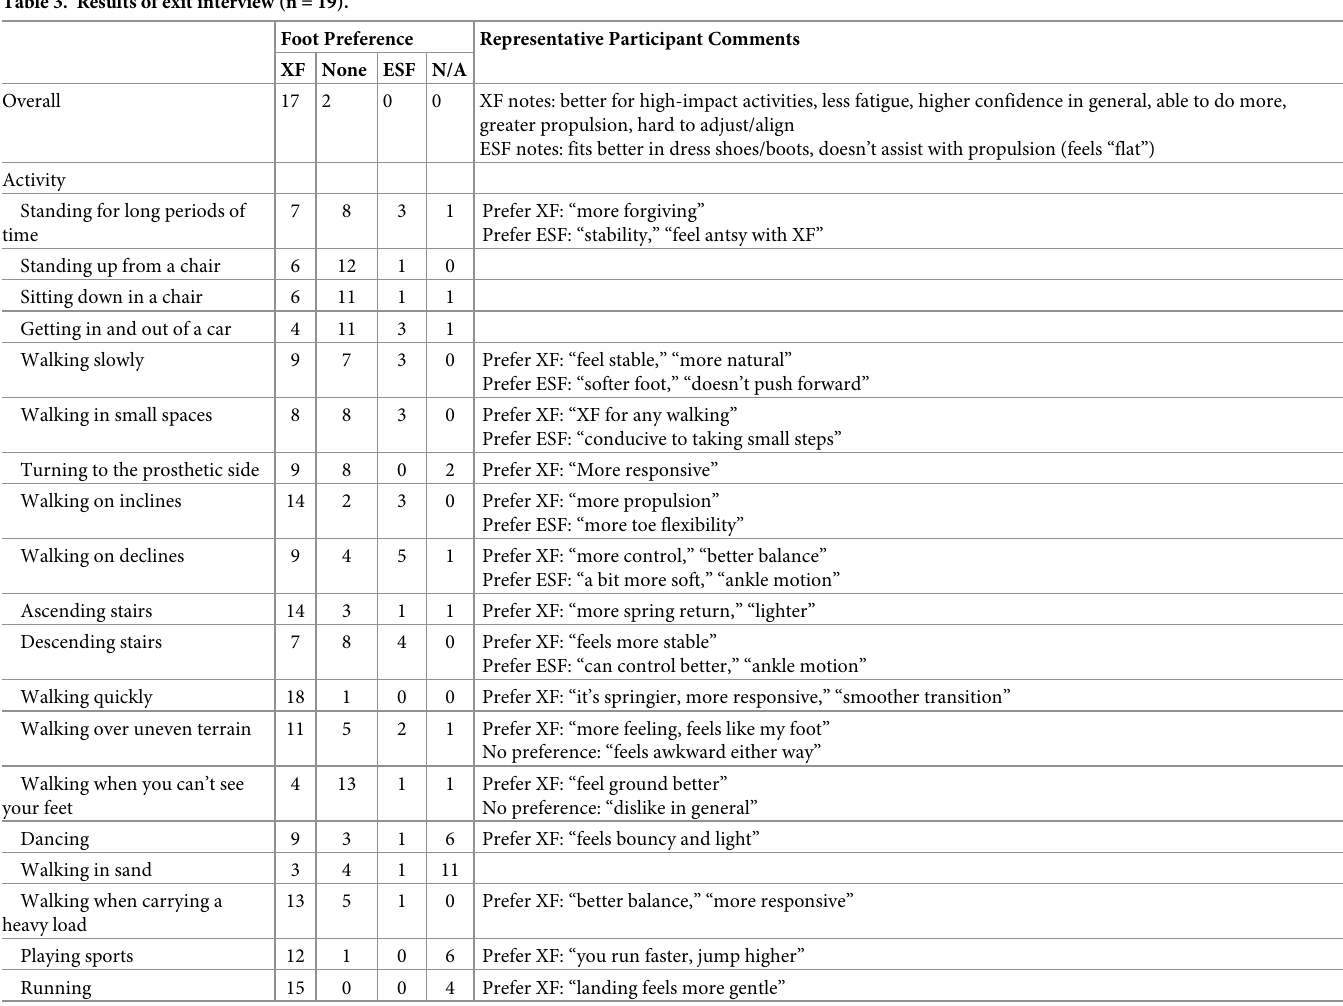
Table 3. Results of exit interview (n =